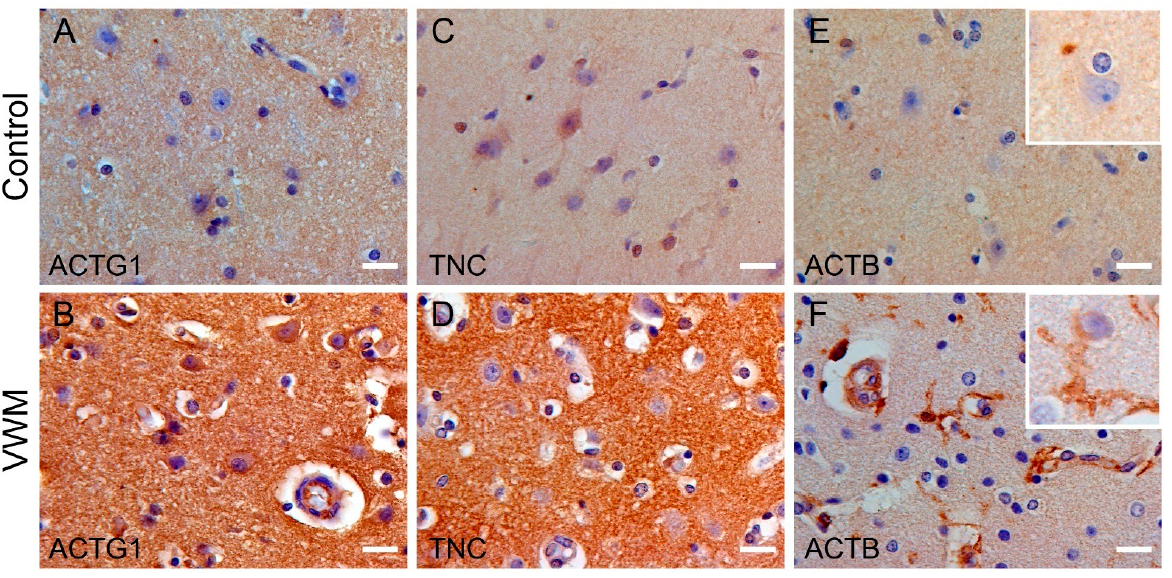
Figure 4. Expression pattern of ACTG1, TNC and ACTB in control and VWM cortices. ( A – F ) Im- munohistochemistry against ACTG1, TNC and ACTB in control cortex ( upper panel ) and VWM cortex ( bottom panel ). Insets in ( E , F ) are higher magnification images, showing cellular immunore- activity of ACTB in VWM cortex, but not in control cortex. Blue stain indicates nuclei. Scale bars: 20 µ m. Depicted images are stains of cortical tissue of control 2 and VWM 1.